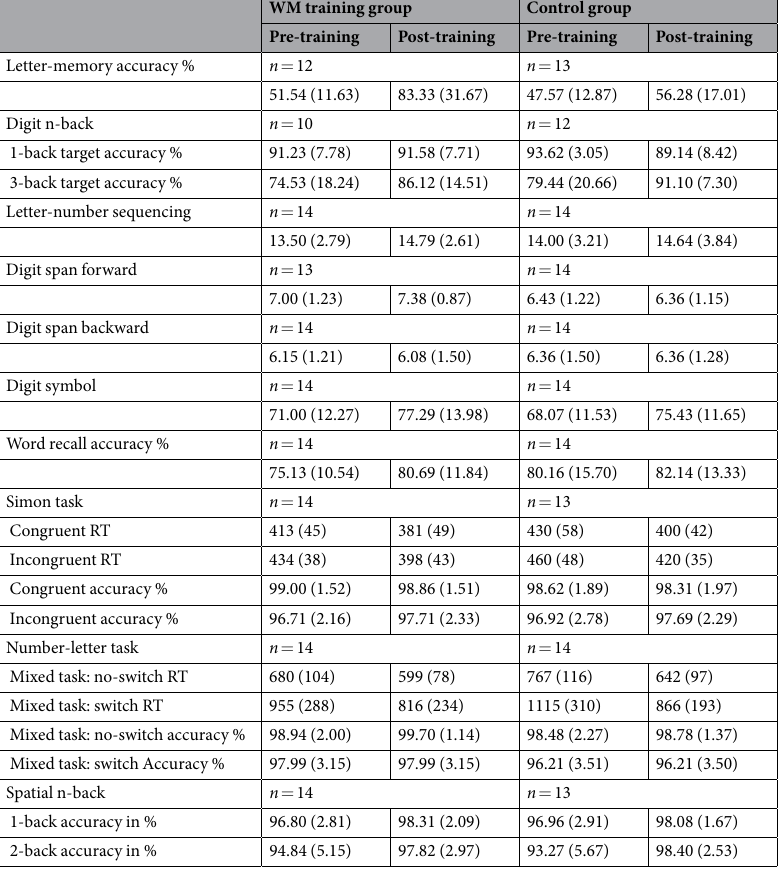
Table 1. Group means ( SD ) on the pre- and post-training cognitive measures.